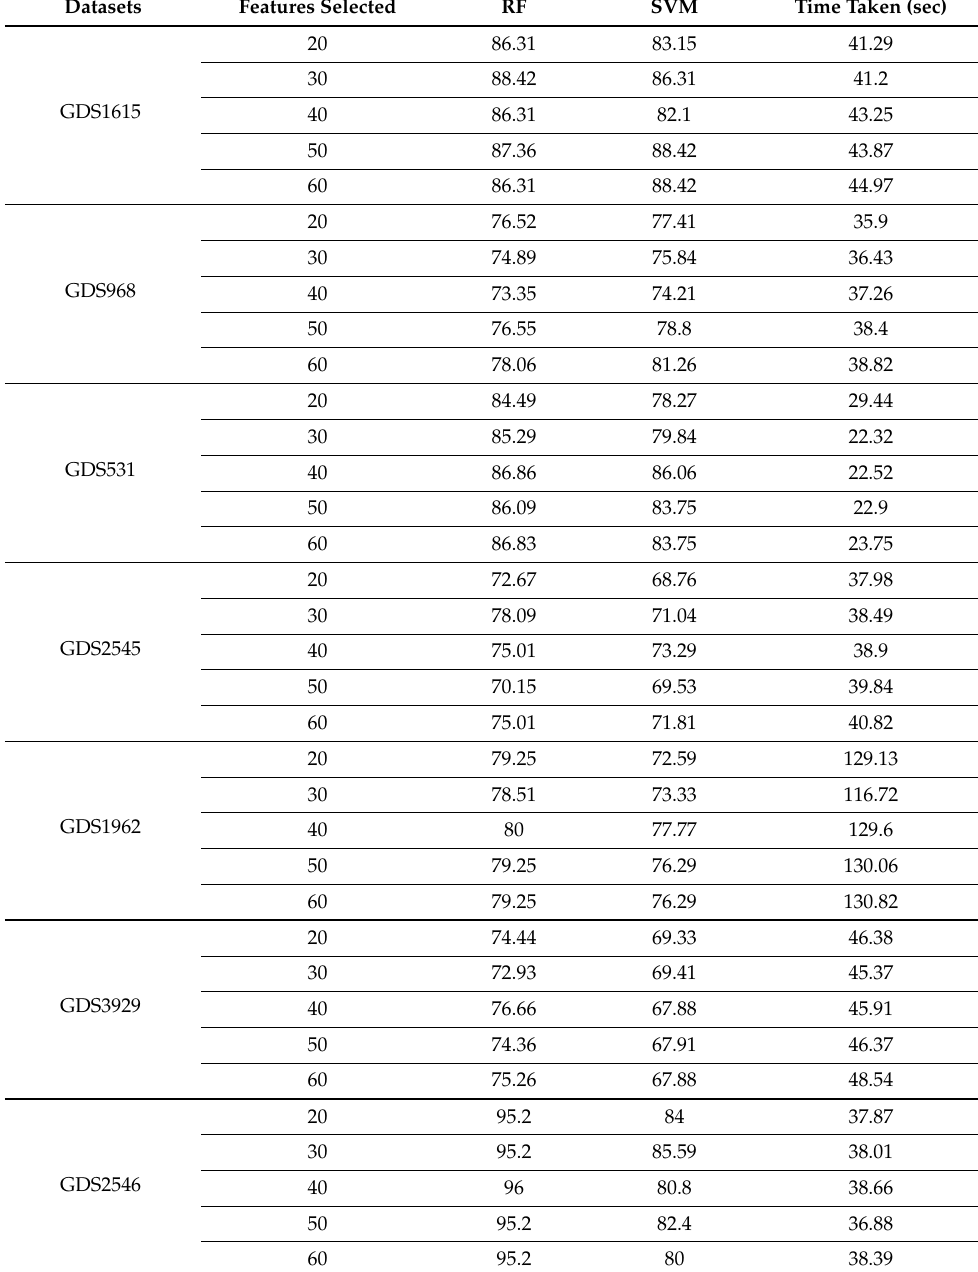
Table 2. Comparativeperformance of accuracy using random forest and support vector